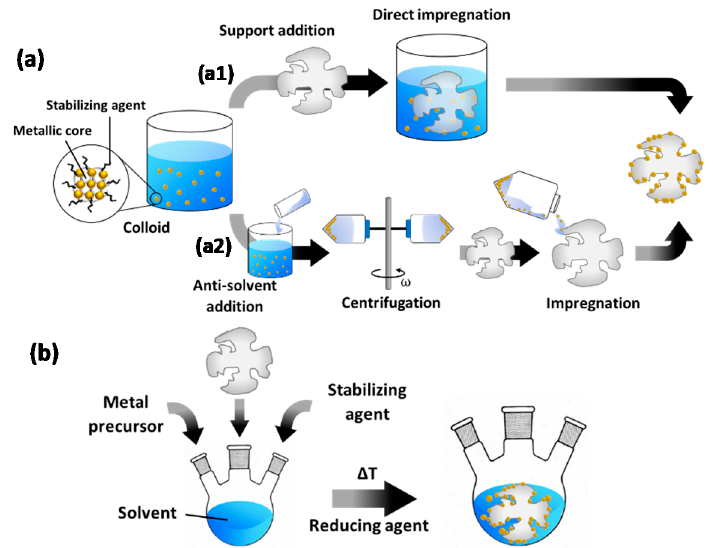
Figure 2. Common methods for supported catalyst preparation via colloidal synthesis. ( a )